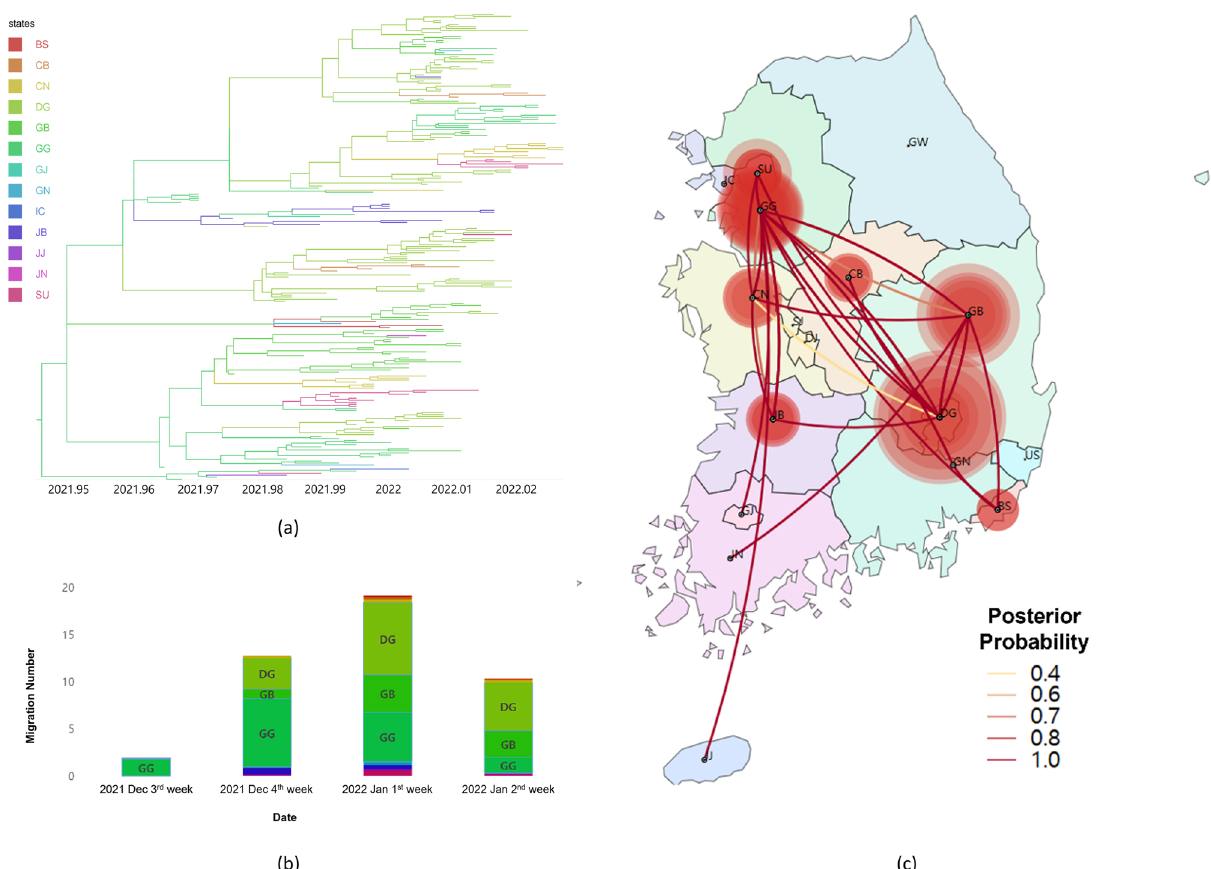
Figure 2. Phylogeographic result of the Kor-O1 subgroup. ( a ) Time-scaled maximum clade credibility tree of the Kor-O1 subgroup. Branches are colored according to their location in South Korea, and the branch thickness indicates the posterior probabilities of the inferred ancestral location. The phylogenetic tree with the virus name is available in Fig. S2. ( b ) Mean number of migration events of the Kor-O1 subgroup from major sources in Korea through time, which was estimated and computed by Bayesian phylogeographic analysis. ( c ) Transmissions of the Kor-O1 subgroup in South Korea visualized by SpreaD3. The color of the lines indicates the posterior probability. The diameters of the circles represent the number of branches maintaining a particular location state in each period. The video of the Kor-O1 transmission history is available on Video S1. ( BS Busan, CB Chungcheongbuk-do, CN Chungcheongnam-do, DG Daegu, GB Gyeongsangbuk-do, GG Gyeonggi-do, GJ Gwangju, GN Gyeongsangnam-do, IC Incheon, JB Jeollabuk-do, JJ Jeju-do, JN Jeollanam-do, SU